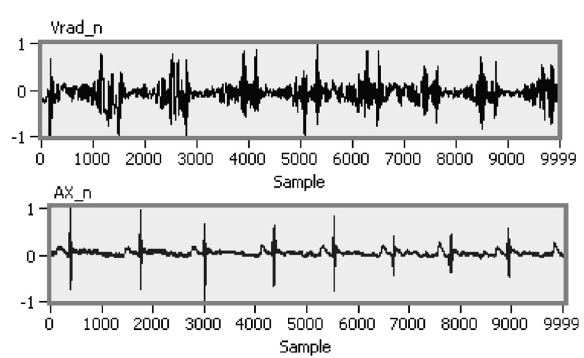
Figure 10. The correspondence between the Vrad_n and AX_n during 2 point gait with two crutches.